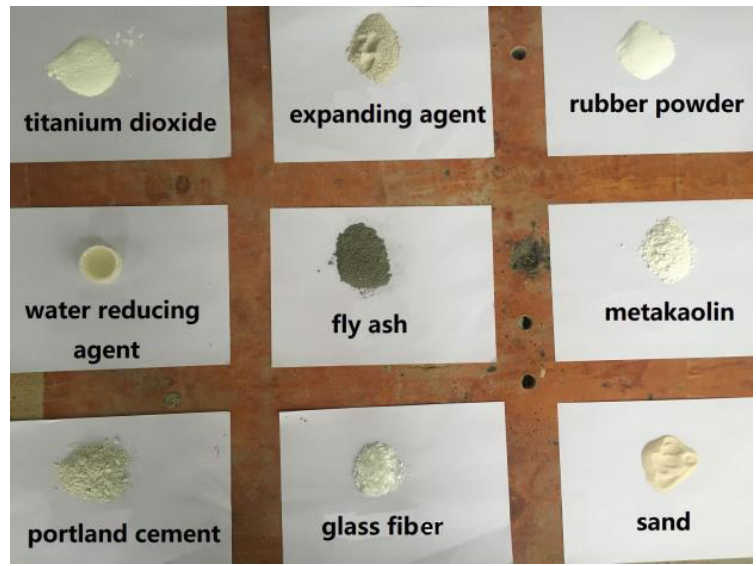
Figure 2. GRC raw materials.